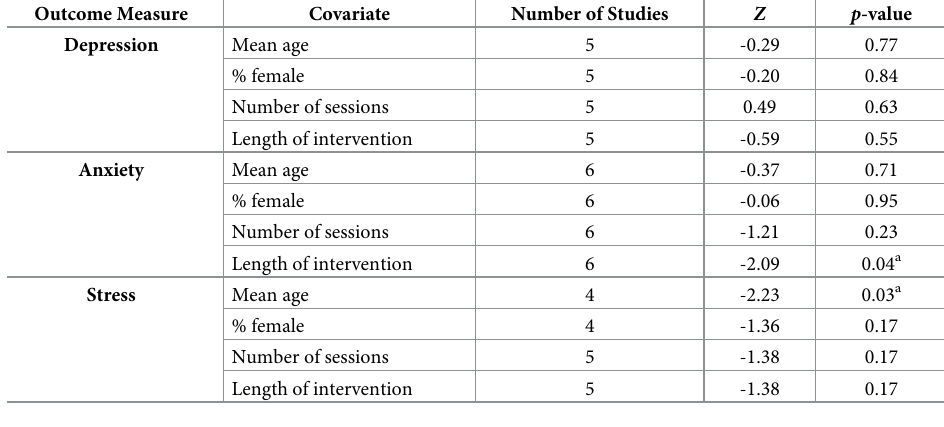
Table 3. Summary of meta-regression analyses of online MBIs effect on mental health outcomes at post-interven- tion (including